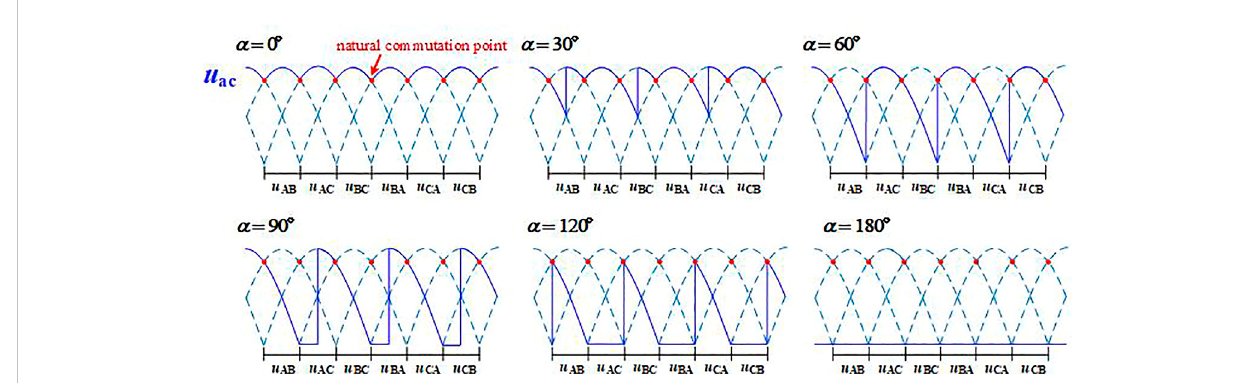
FIGURE 4 Typical waveform of u ac at different fi ring angles of the SCRs in the improved VSC.